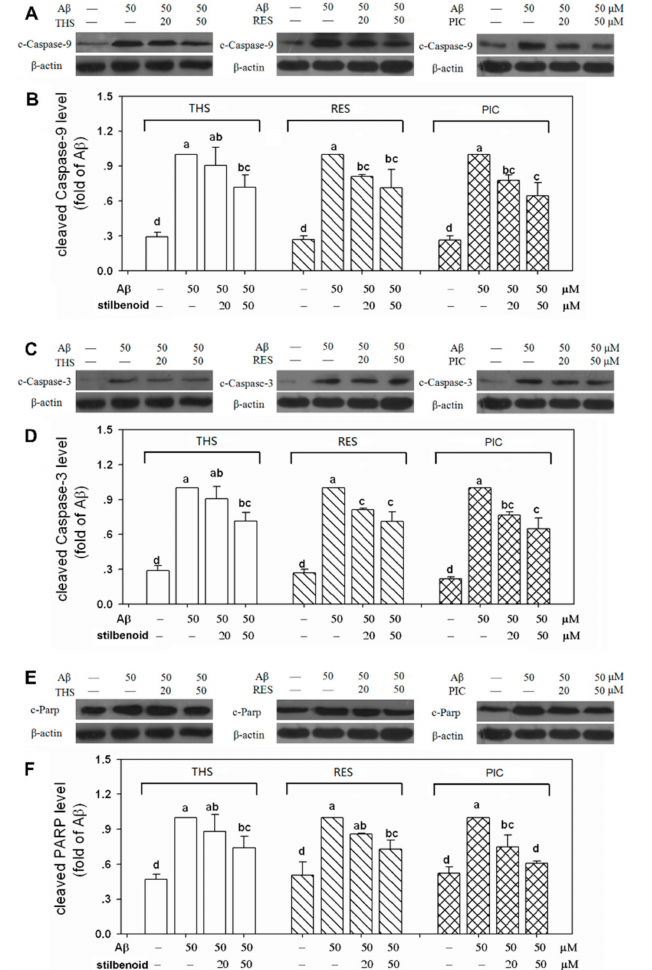
Figure 5. Effects of trans -4-hydroxystilbene (THS), resveratrol (RES), and piceatannol (PIC) on ( A , C , E ) multiple caspase expression in A β 25-35 -induced rat primary cortex neurons. Western blotting was used to analyse the cleavage of caspase-9, caspase-3, and PARP. The relative protein levels were calculated and are presented in ( B , D , F ). Each bar represents the mean ± SD of three independent experiments. Different letters in each figure indicate significant differences by Duncan’s multiple range test at p <